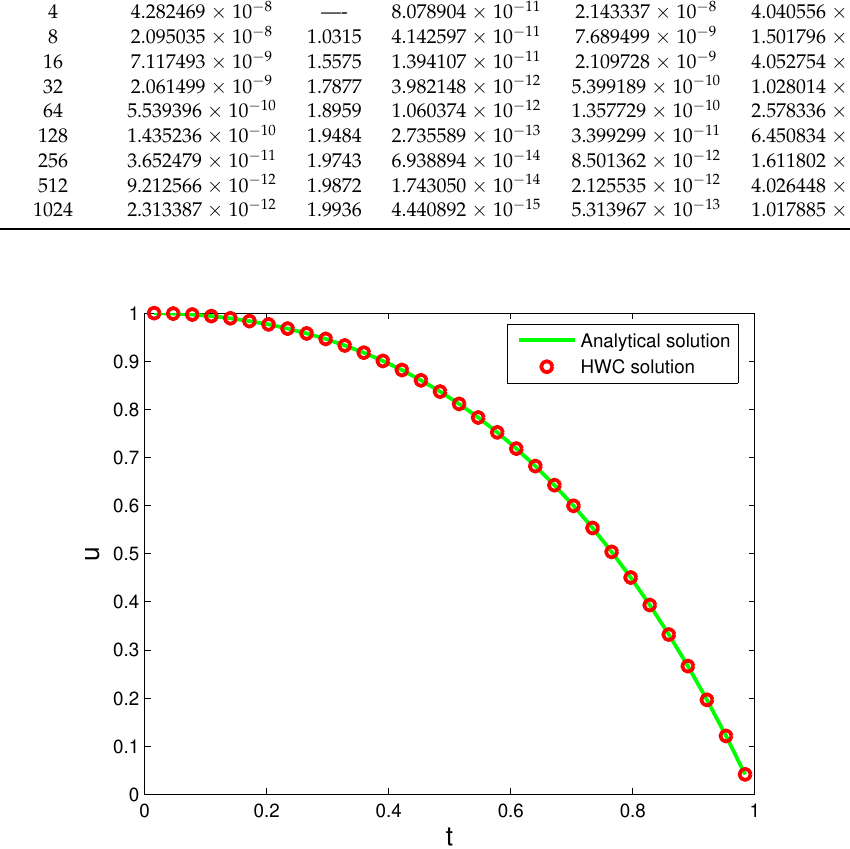
Figure 3. Comparison of numerical and analytical solutions for 32 CPs of Problem